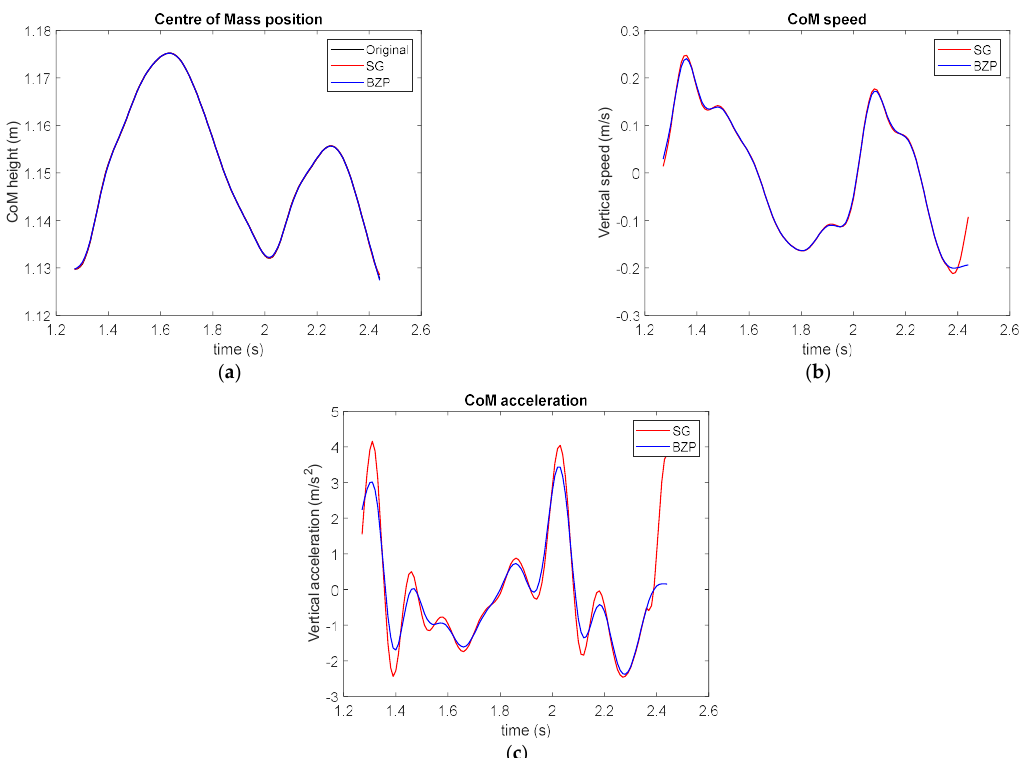
Figure 10. CoM vertical position ( a ), speed ( b ) and acceleration ( c ) during a gait cycle.